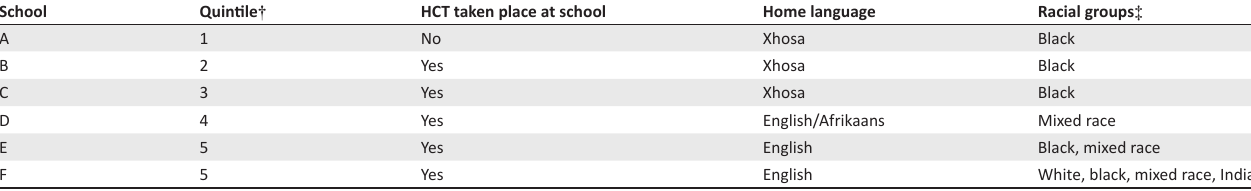
TABLE 1: Profile of selected schools.